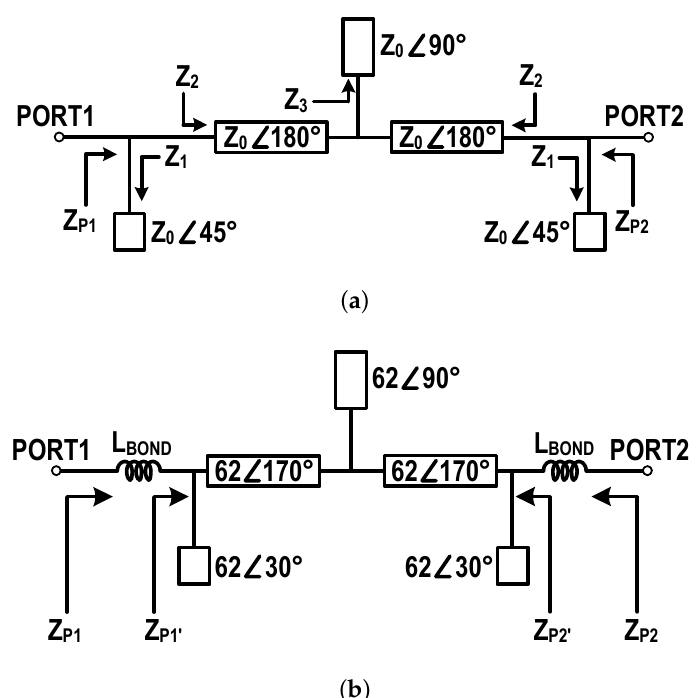
Figure 8. Schematics of the RFIN, ( a ) ideal configuration and ( b ) practical configuration including bond wires.